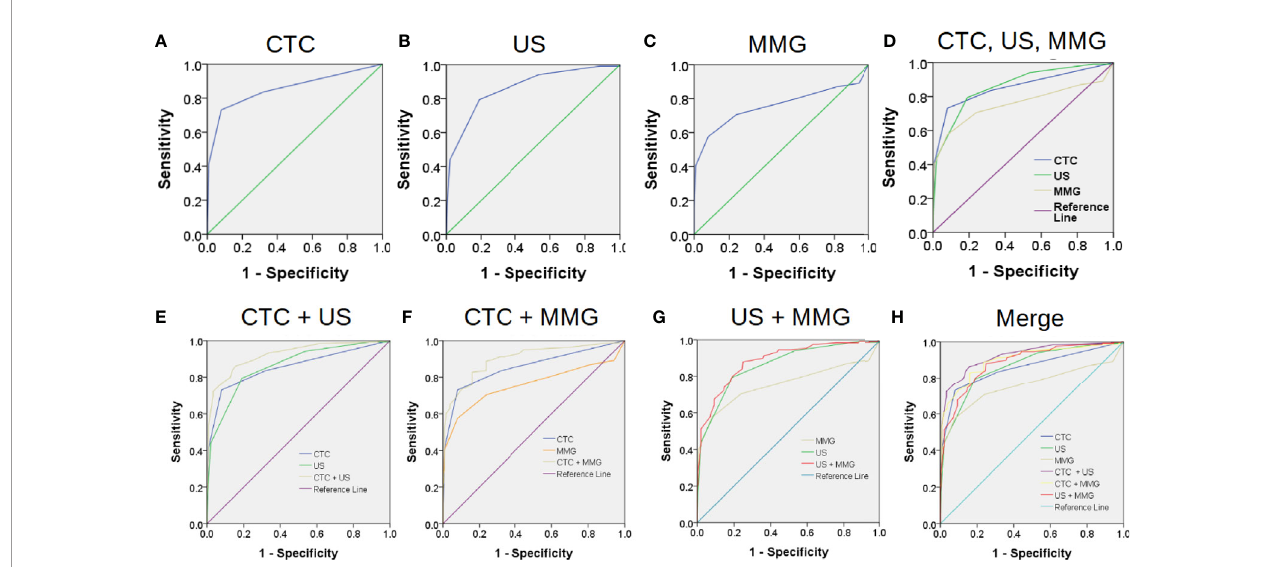
FIGURE 2 | Combination of conventional medical imaging examinations with CTC enhances the diagnostic ef fi ciency for BC. The performances of CTC, US and MMG in BC diagnosis are shown in (A – C) by the receiver operating characteristic (ROC) curves. Area under the curve (AUC) of CTC, US and MMG are 0.855, 0.861 and 0.759, respectively. CTC exhibits a similar diagnostic performance as US as shown in (D) . Combination of CTC enhances the performances of US and MMG in BC diagnosis as shown in (E, F) with AUC increasing from 0.855 to 0.922 and 0.759 to 0.899, respectively. However, combination of MMG with US does not improve the diagnostic performance of US much as shown in (F) with AUC increasing slightly from 0.855 to 0.884. “ CTC + US ” gives the best diagnostic performance, while “ CTC + MMG ” and “ US + MMG ” have similar improved diagnostic performances as shown in (H) .